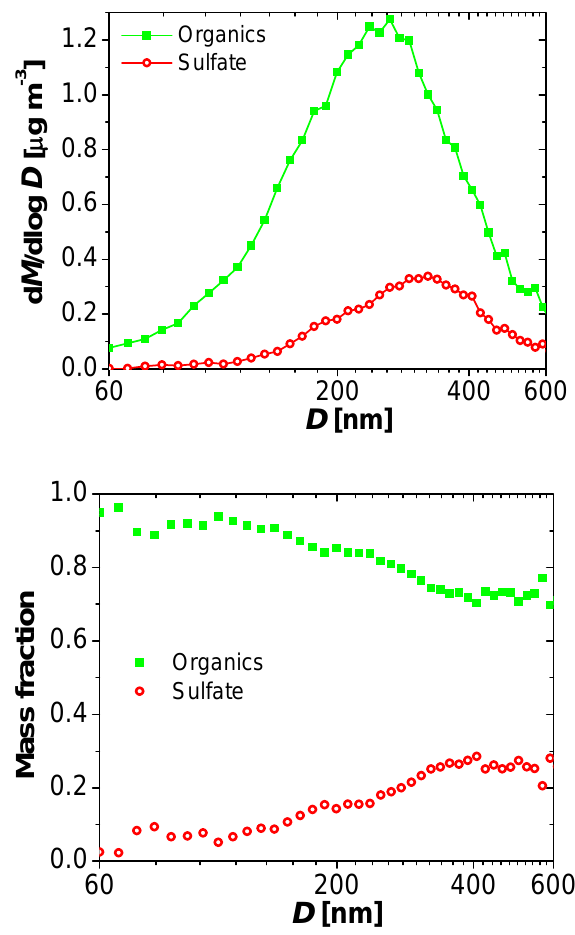
Fig. 11: Mass size distributions (a) and corresponding mass fractions (b) of organics and sulfate determined by aerosol mass spectrometry (AMS) averaged over the entire campaign (CCN measurement period). The diameter values ( D ) are approximate mobility equivalent diameters calculated by division of the AMS vacuum aerodynamic diameter through 1.4 (dimensionless density scaling factor).